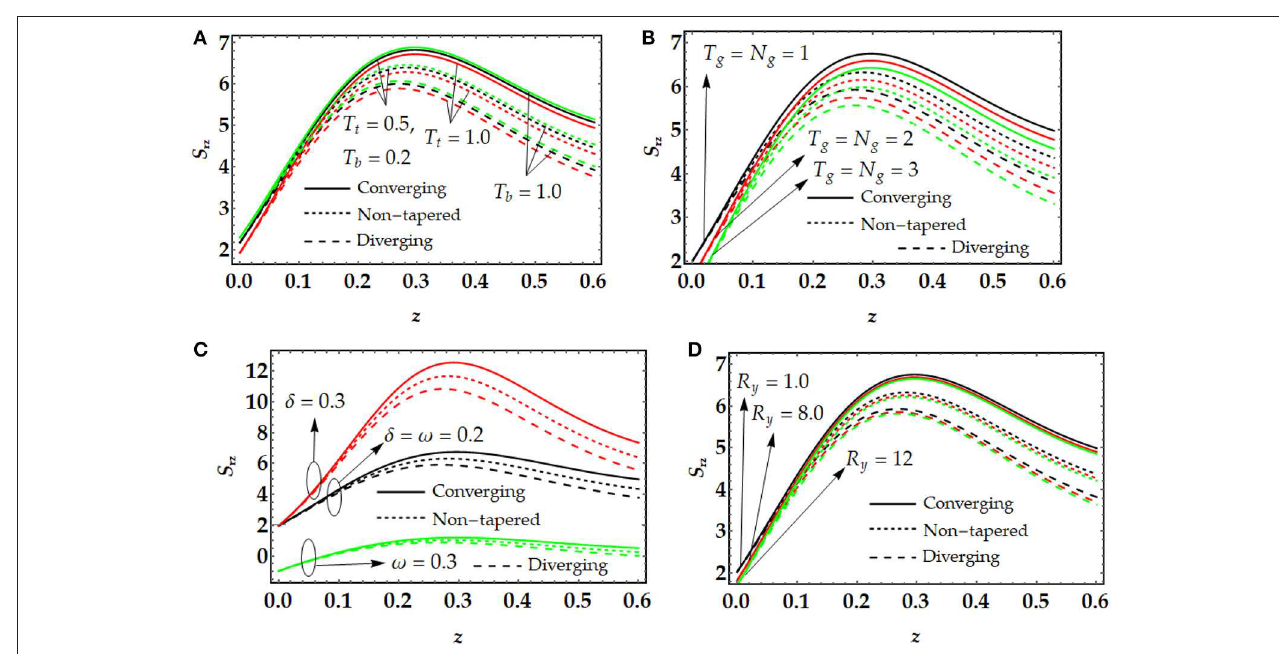
FIGURE 6 | Wall shear stress for multiple values of (A) T t and T b , (B) T g and N g , (C) δ and ω , (D) R y .